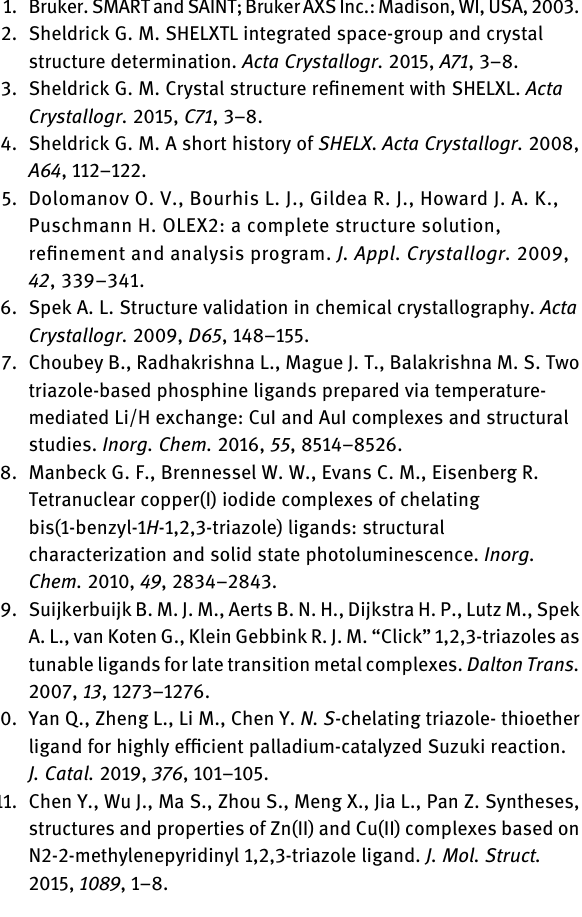
The title compound crystallizes in the monoclinic P 2 space group with one title complex in the asymmetric unit.